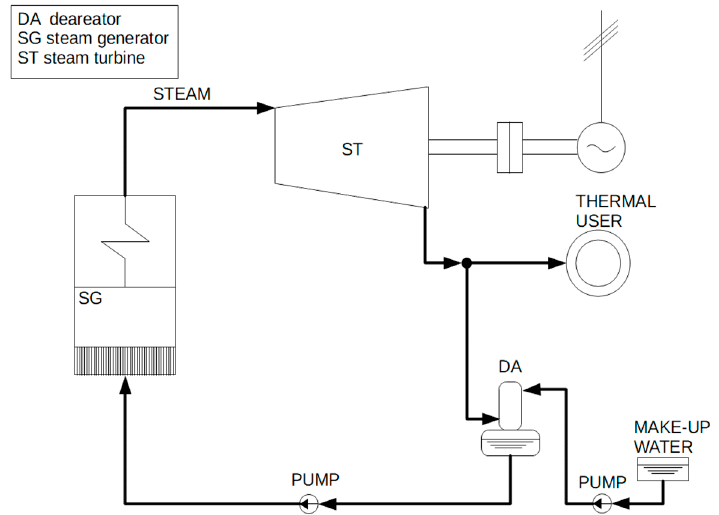
Figure 5. Scheme of the steam power plant with back-pressure turbine cogeneration unit taken into consideration.